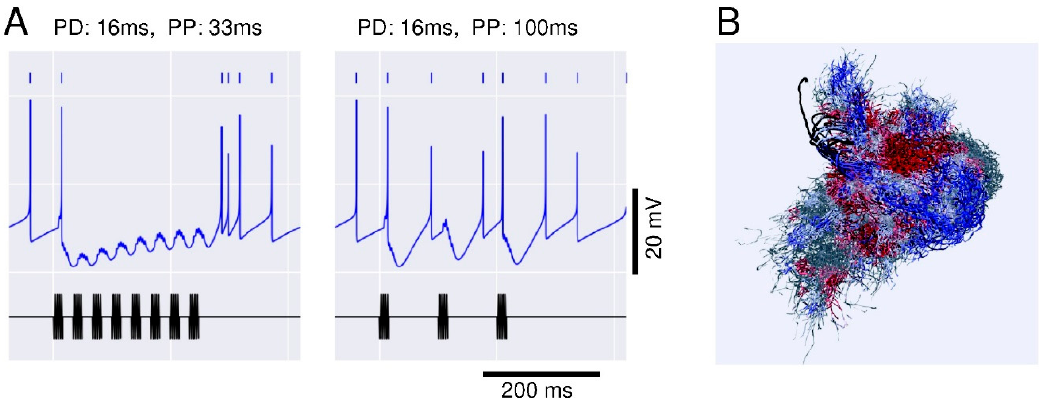
Figure 5. ( A ) Responses of model DL-Int-1 neurons in network simulations of the disinhibitory circuit (see Figure 3D) to antennal vibration pulse trains. Black traces: Antennal stimulus. Blue traces: Model membrane potential. Spike times are in addition indicated by blue vertical lines. Modified from Kumaraswamy et al. [63]. ( B ) Region-dependent changes in dendritic density between young and forager bees. Co-aligned morphologies of 12 DL-Int-1 neurons. Color indicates regions of decrease (red) and increase (blue) of local average dendritic density in neurons of foragers relative to neurons of newly emerged adults. Modified from [64].